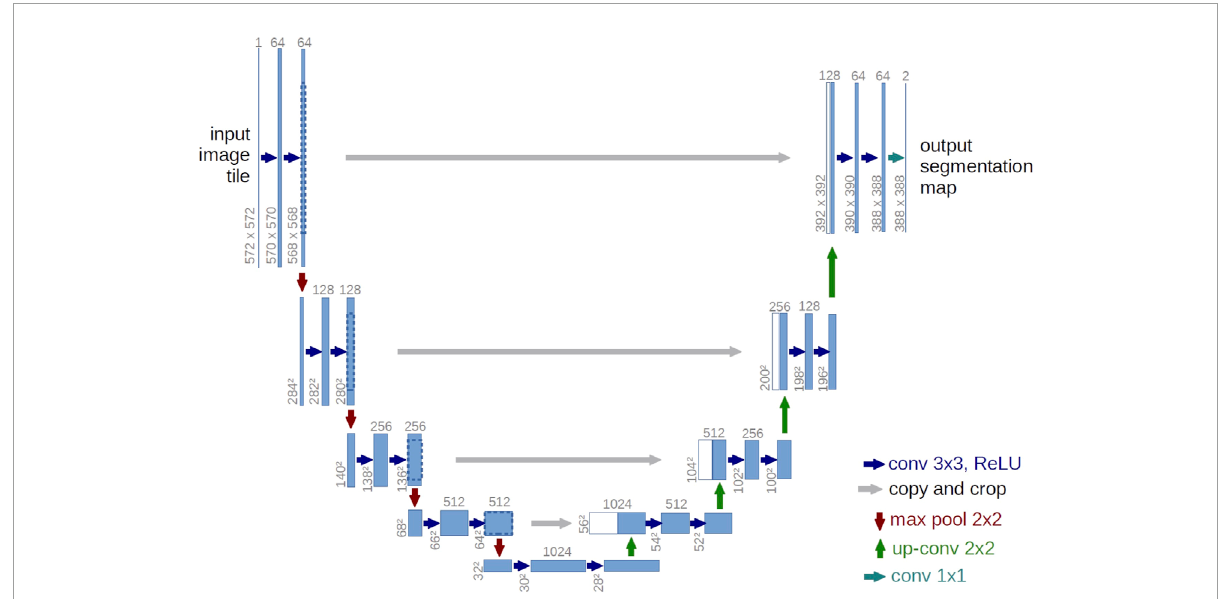
FIGURE 1 The global Unet architecture. Note that the input dimensions are 128 × 128 in our case. The number of channels for each feature map is indicated on the top of the blue rectangles. Here, there are 64 base filters. The different scales in this model help analyze the images at multiple resolutions. Credit: Ronneberger et al.